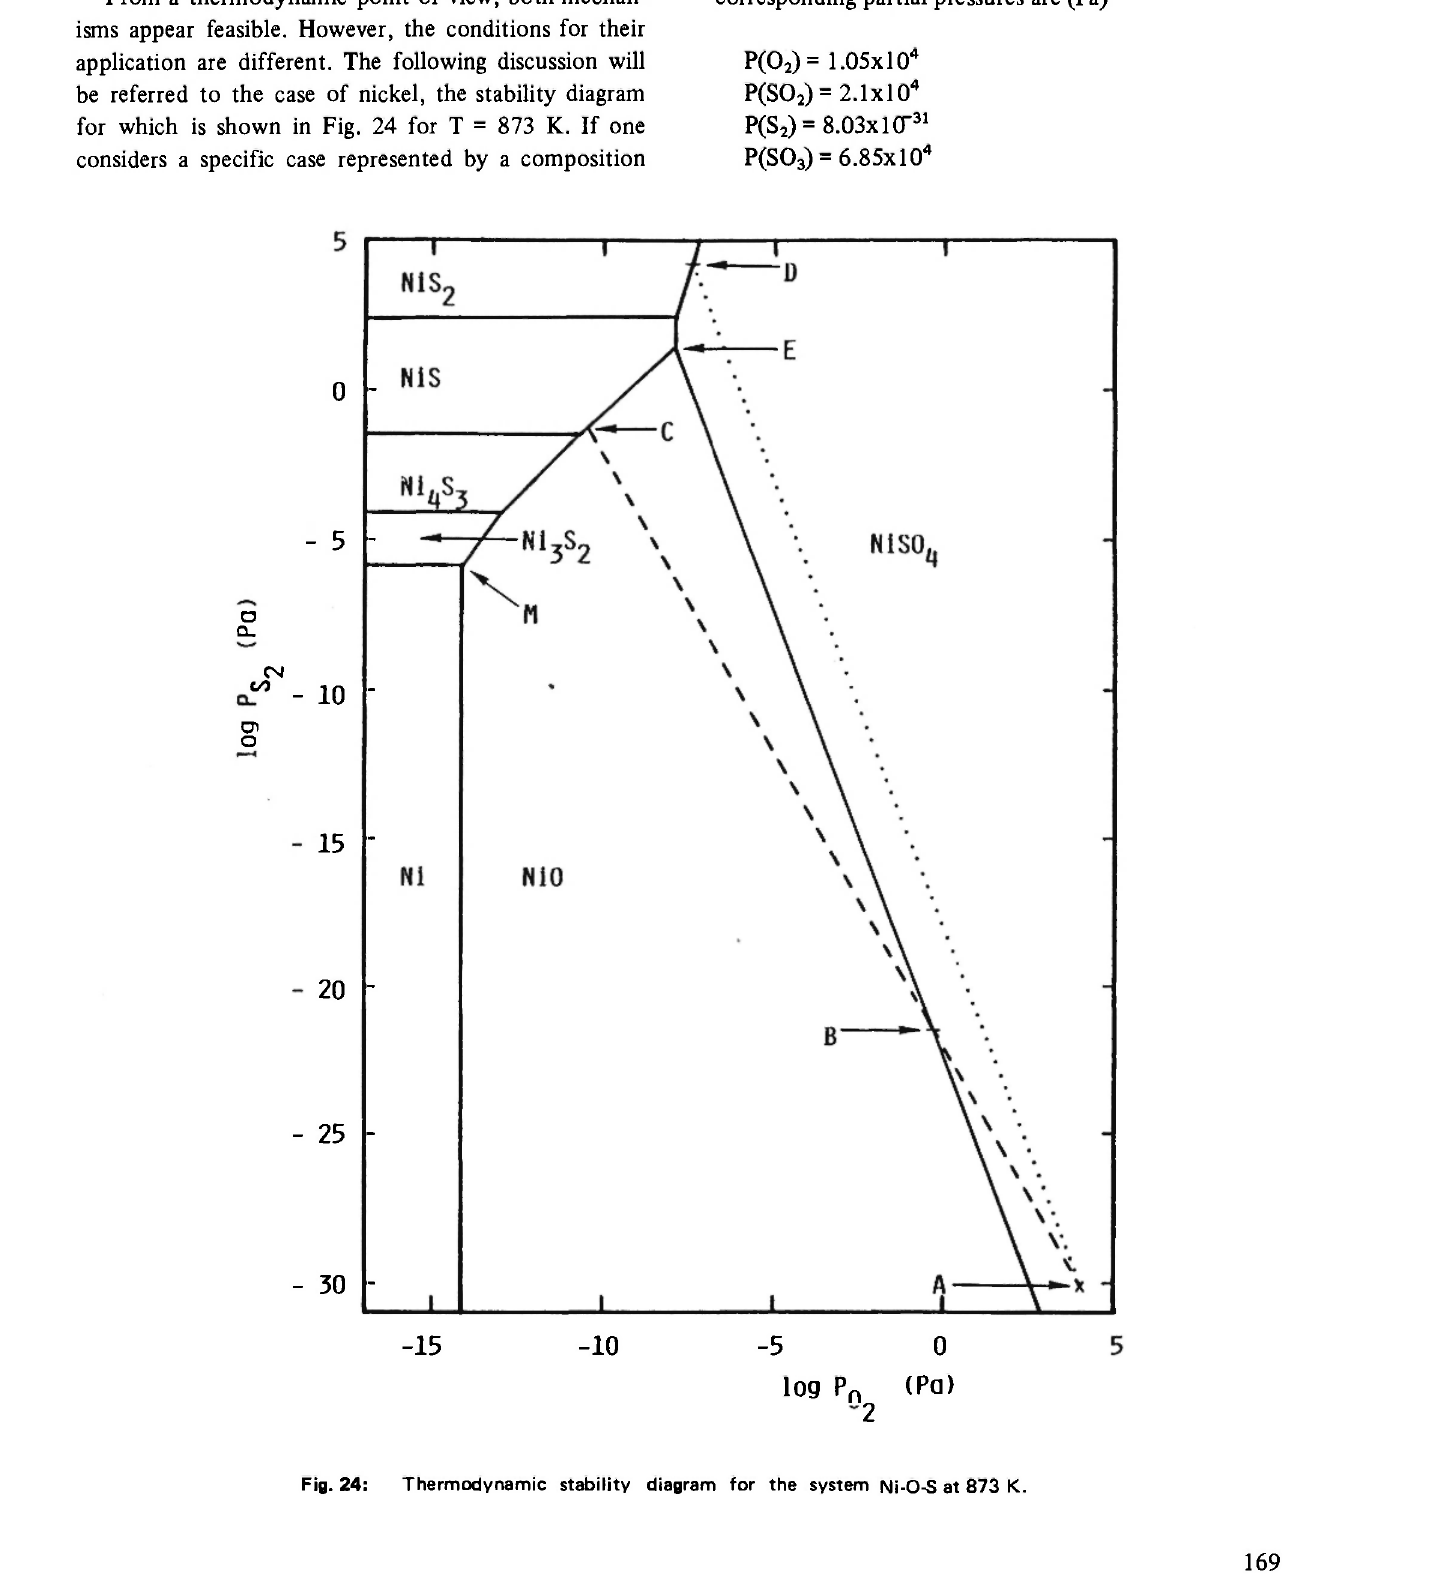
Fig. 24: Thermodynamic stability diagram for the system Nj-O-S at 873